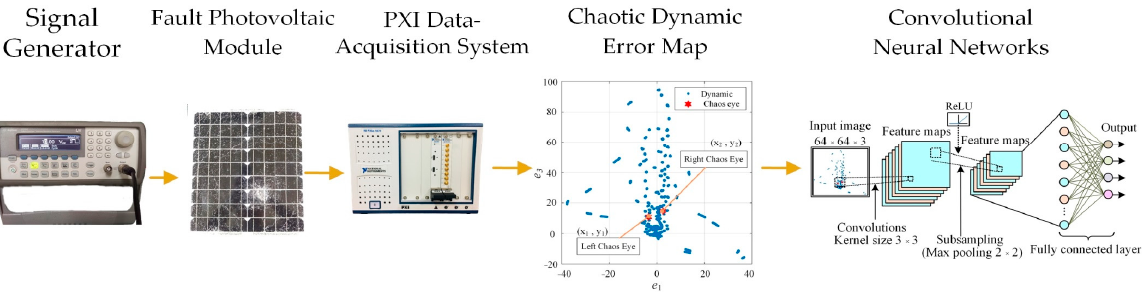
Figure 1. Architecture of system.